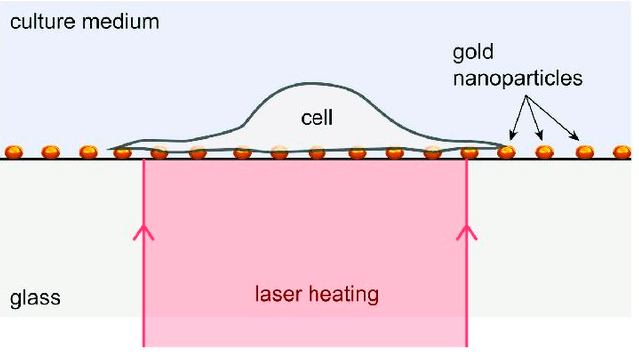
Figure 26. Schematic diagram of the device: RPE cells attached to a layer of gold nanoparticles acts as heat sources under laser activation. Reprinted with permission from ref. [171]. Copyright © 2018 John Wiley and Sons.